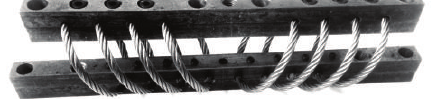
Figure 1: O-type wire-cable vibration isolator.